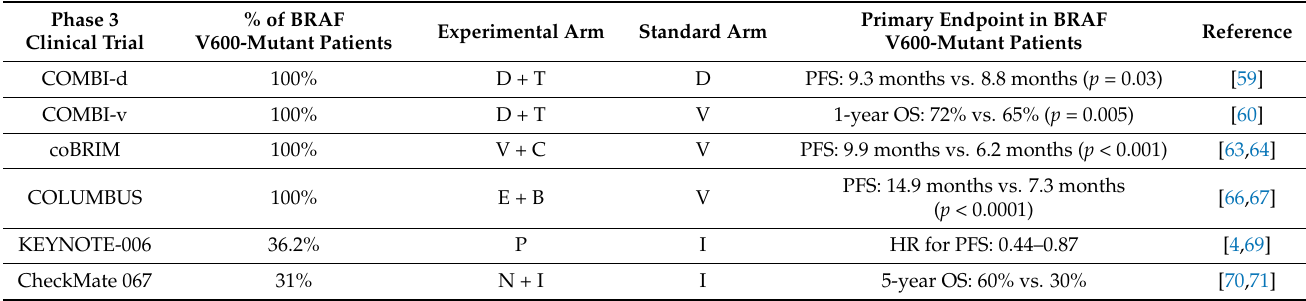
Table 2. Phase 3 clinical trials in BRAF V600-mutant metastatic melanoma patients. Phase 3 Clinical